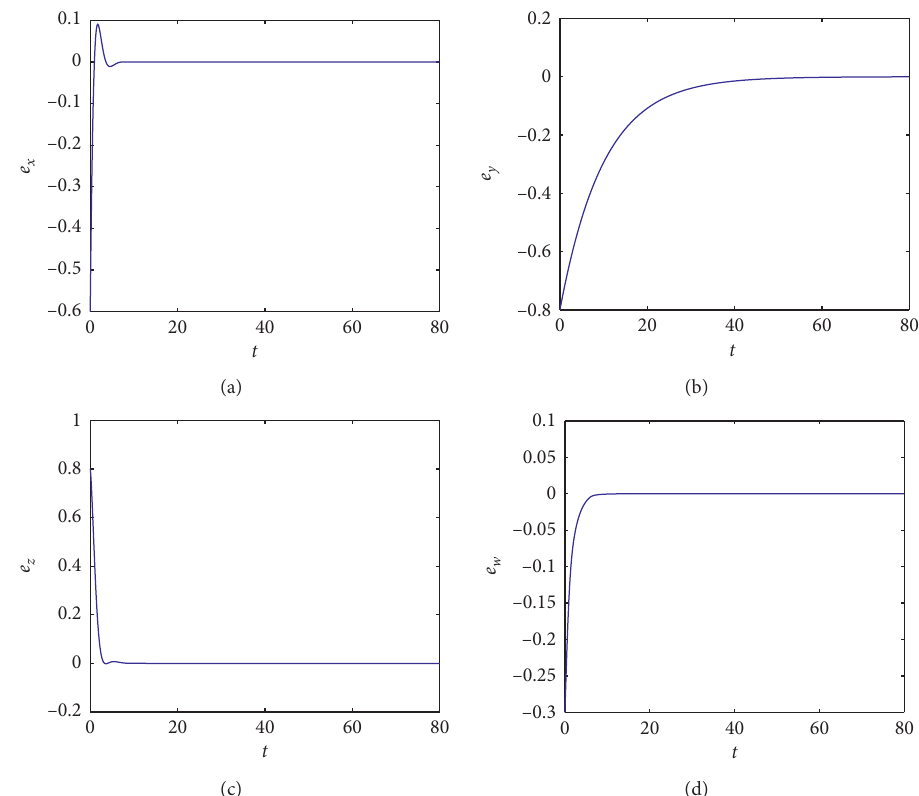
Figure 2: Time history of error system (4) under the control law given in Theorem 1. The values of parameters are the same as those in Figure 1.